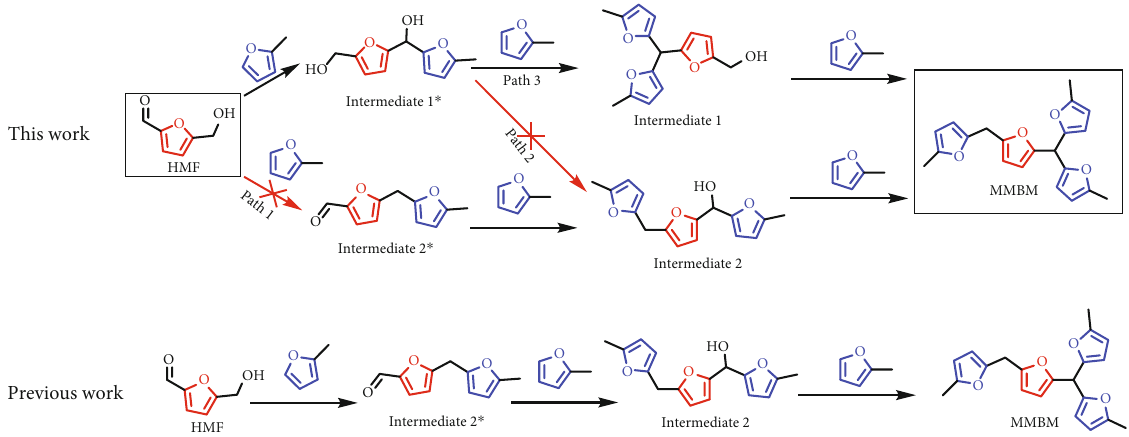
Scheme 3: Comparison of reaction pathways for the conversion of HMF and 2-MF to MMBM in this work and reported